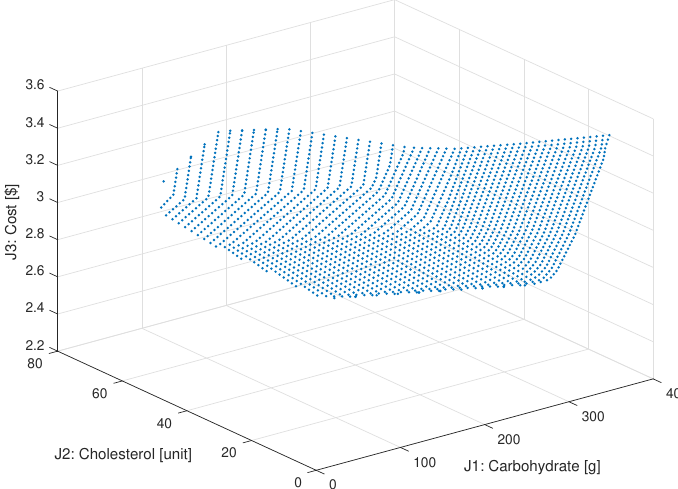
Figure 8. Pareto front approximation obtained for daily diet